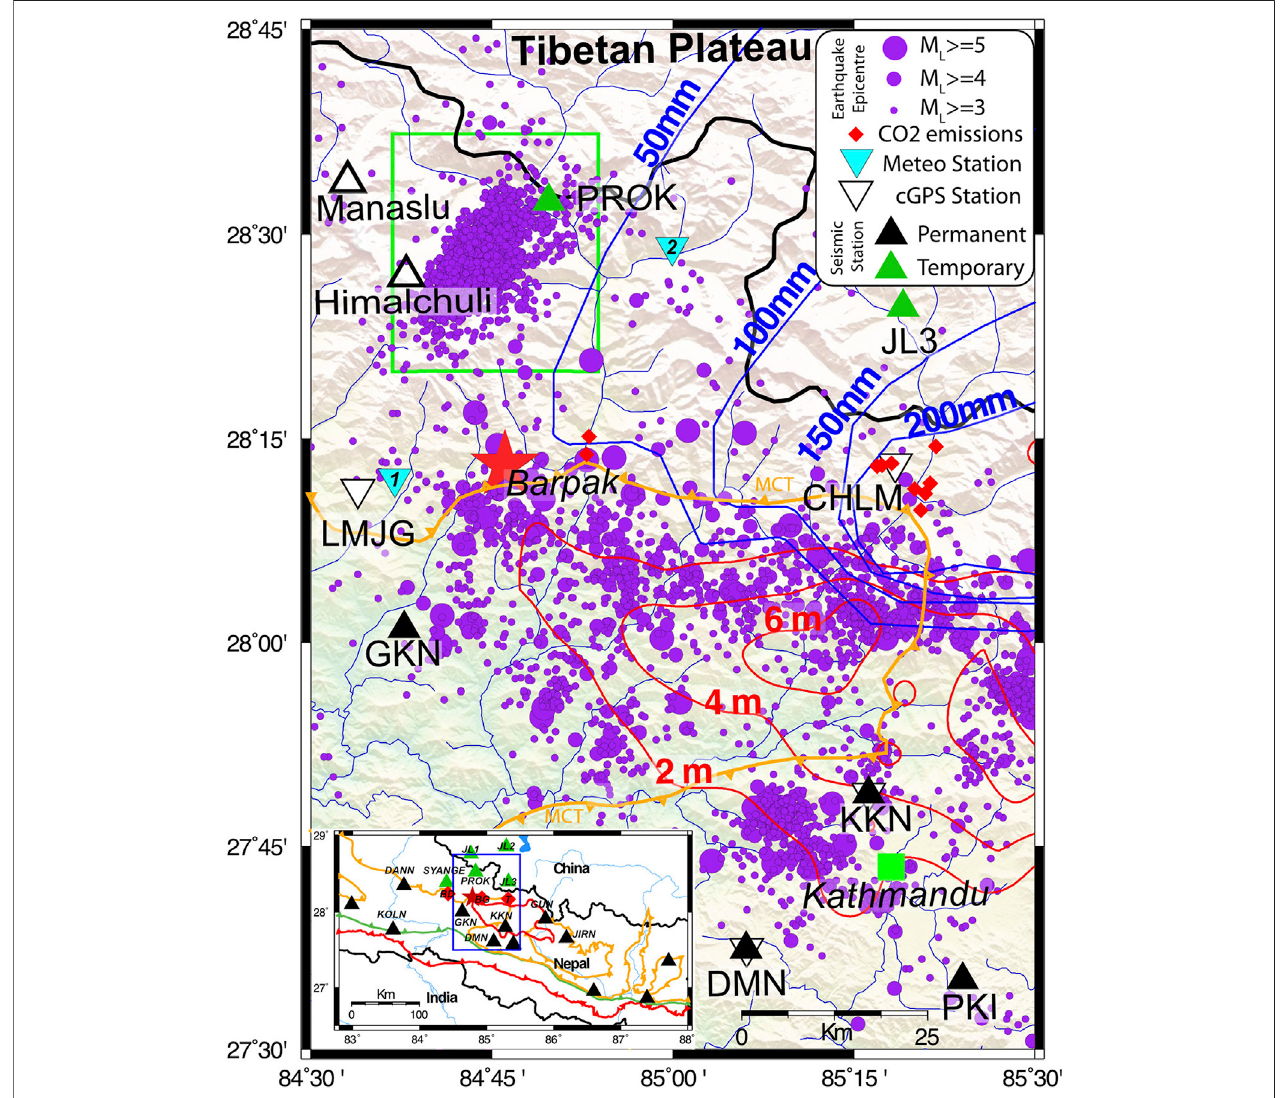
FIGURE 1 | Seismicity after the Mw 7.8 Gorkha earthquake of April 25, 2015. Earthquakes with local magnitude ML ≥ 3.0 are recorded by the permanent NSC network(stationsshown ininset)plottedinpurplecircles. Red starrepresentstheGorkhamainshock. Green triangles represent thetemporaryseismic stations installed following the activation of Himalchuli swarm. Light blue triangles represent the meteorological stations (numbers 1 and 2 respectively for Gharedhunga and Chhekampar).Redcontourscorrespondtocoseismicslip(Grandinetal.,2015).Bluecontourscorrespondtopost-seismicslipdeducedfromcGPSstations(Zhao et al., 2017). At a larger spatial scale, the insetpresents the seismic stations (black triangle), and three CO 2 emission sites (red diamond), where BD, BG, and T stand for Bahundanda, Budhi Gandaki, and Trisuli sites, respectively.